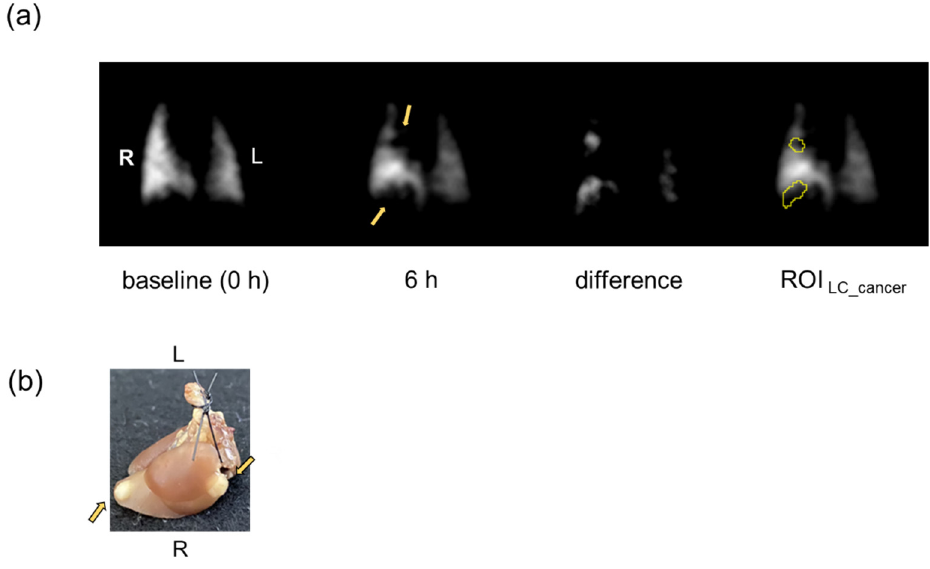
Figure 1. Example of ROI setting on HP 129 Xe lung image. The ROI LC_cancer was depicted using the difference image between the baseline image (0 h) and the image acquired at each time point (3, 6, and 24 h) post administration of IONPs; e.g., image 6 h post administration of PEG-IONPs shown. The arrows indicate locations of lung cancer which were qualitatively determined from comparison of the image ( a ) with photographs ( b ) of excised lung. R, right lung; L, left lung. The time course analysis of images was made for each ROI of cancer and no cancer.